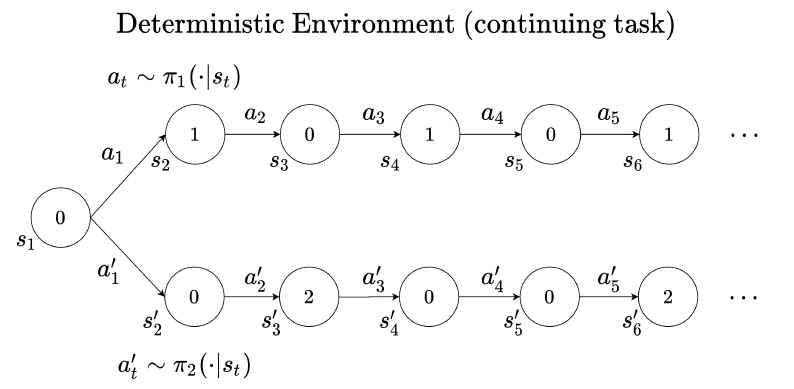
Figure 1. Example of trajectory in a deterministic environment.